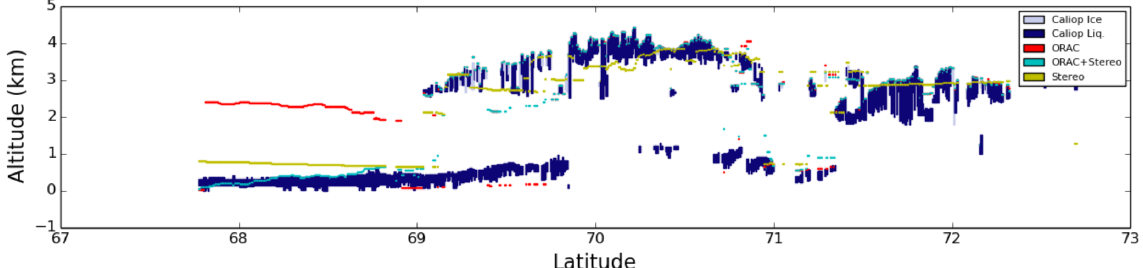
Figure 5. This profile plot show the 1km CALIOP cloud profile for orbit with the time stamp 2008-07-05T13-02-15ZD. Over plot are the collocated CTH data from ORAC, ORAC + stereo, and census stereo. The key in the plot indicates the relationship between colour and feature type.